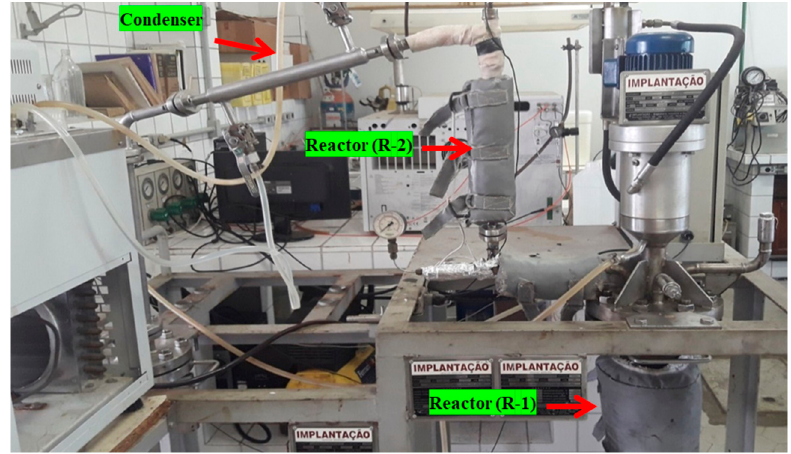
Figure 2. Thermal catalytic cracking unit with a pyrolysis reactor (R-1) and a fixed bed reactor (R-2) in semi-pilot scale.